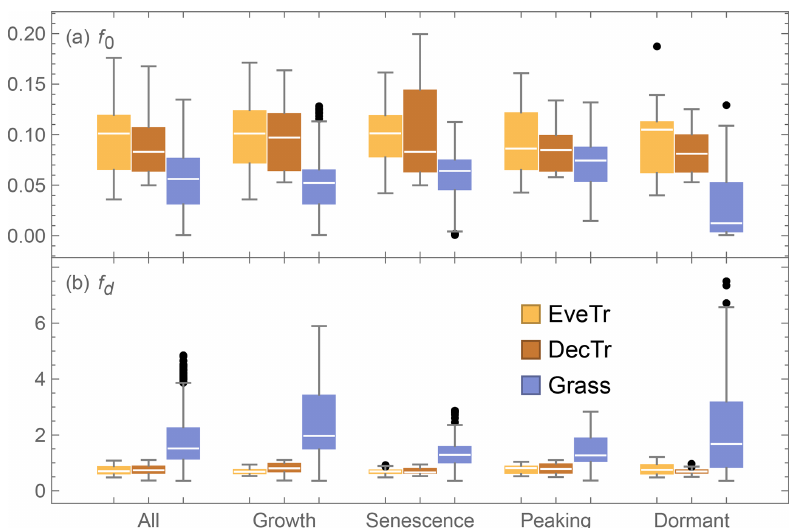
Figure B1. Relations between canopy height ( H c ) and (a) roughness length for momentum ( z 0m , Eq. B2) and (b) displacement height ( z d ,